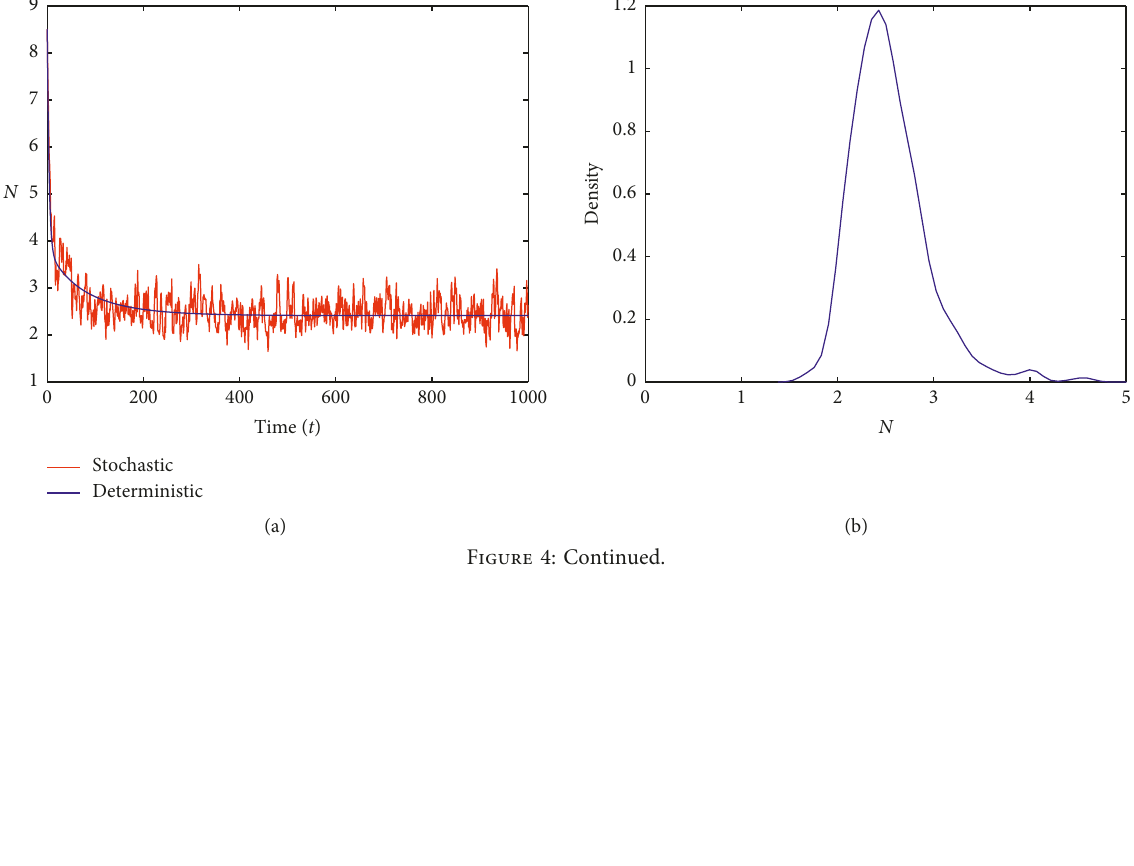
is globally asymptotically stable but the ∗ with x � 0 . ∗